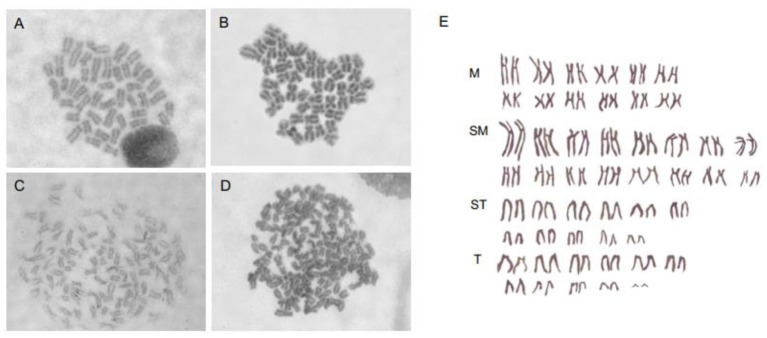
Chromosomes preparation by SP600125 pretreatment in vitro and in vivo. (A,B) Chromosome splitting phases of blunt snout bream from caudal fin cell and kidney tissue, respectively. (C,D) Chromosome splitting phases of red crucian carp from caudal fin cell and kidney tissue, respectively. (E) Chromosomal karyotype of red crucian carp.